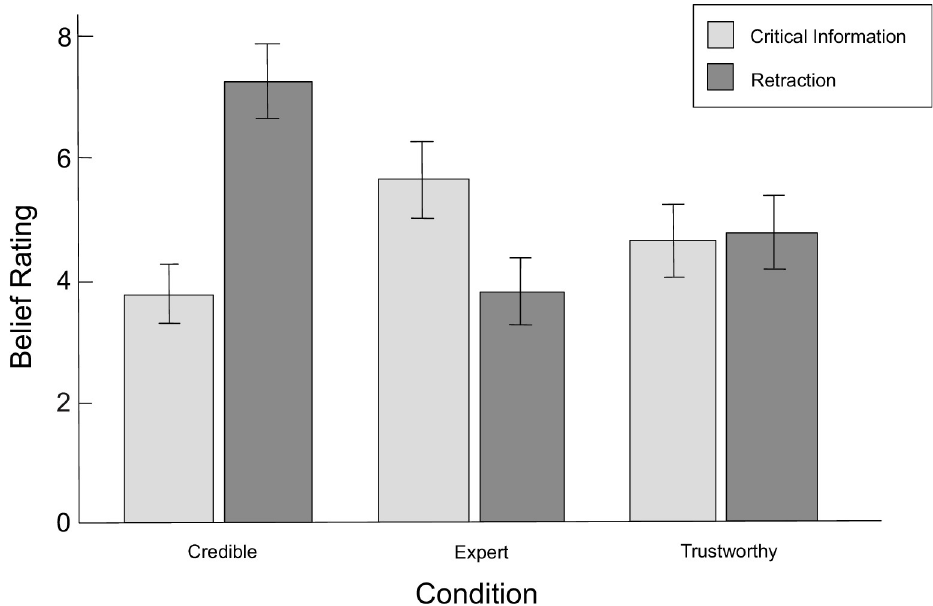
Fig 3. Mean belief ratings in the inoculation condition. Credible credible source condition (high in trustworthiness and in expertise); Expert expert source condition (high in expertise, low in trustworthiness); Trustworthy trustworthy source condition (high in trustworthiness, low in expertise). Error bars represent 95% confidence